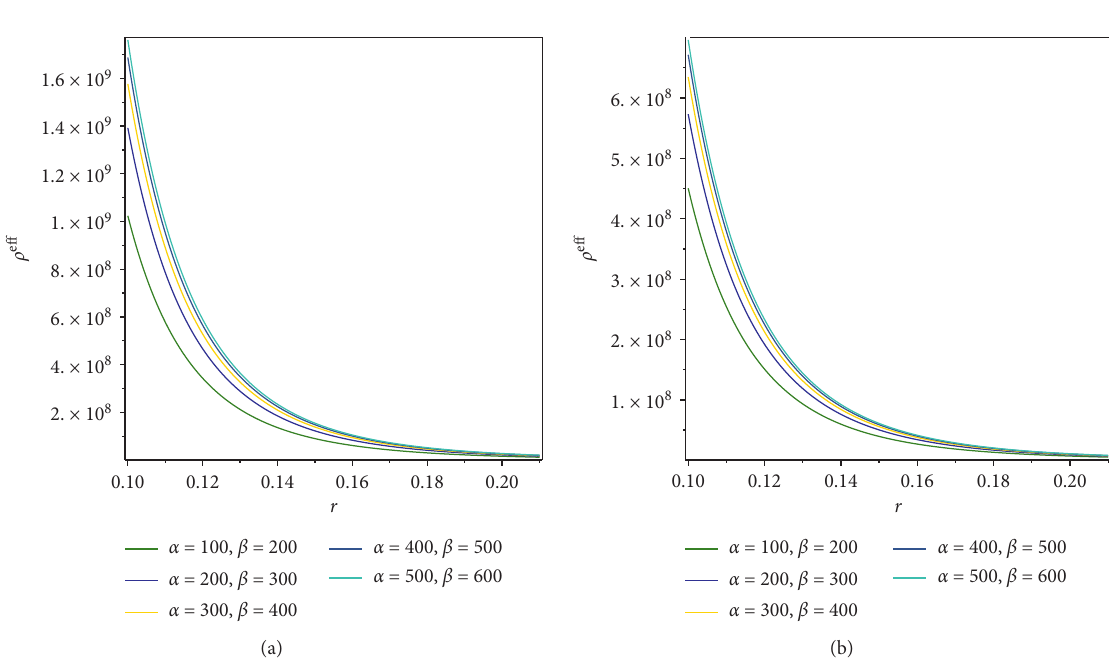
Figure 4: Plots of effective matter variables corresponding to r